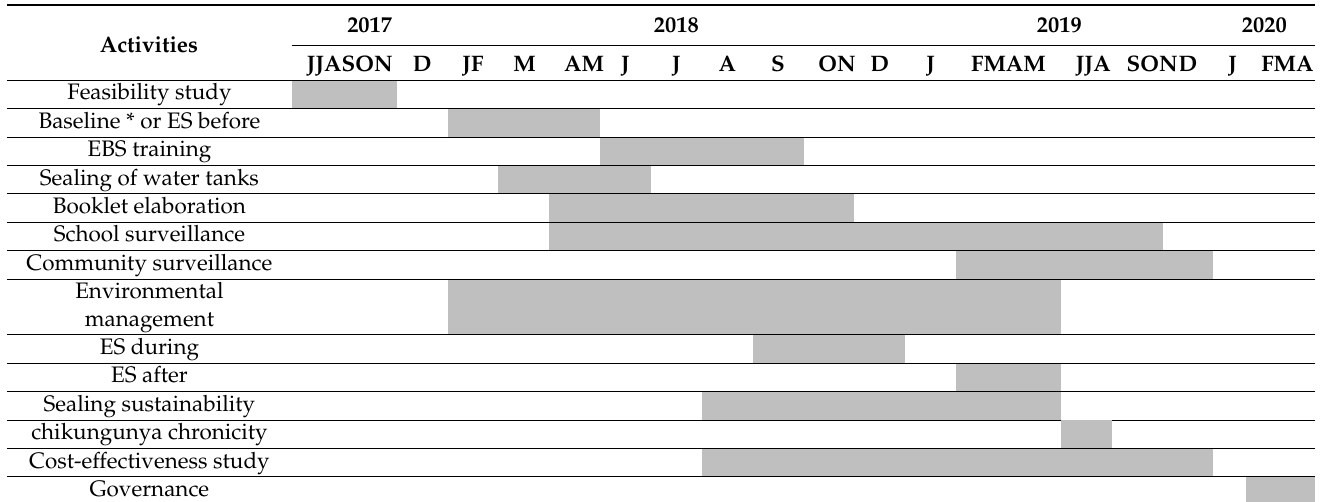
Table 2. Summary of the research activities